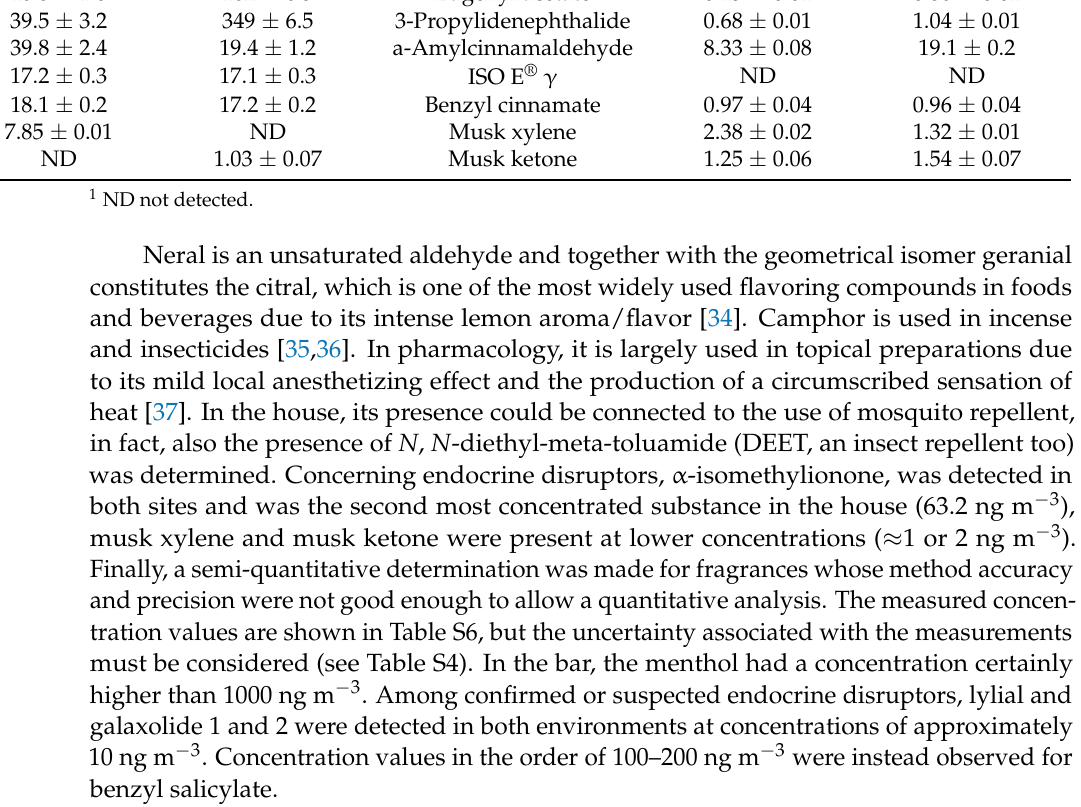
68.5 ng m − 3 (pharmacy and hairdresser respectively), and galaxolide was in the range of 47.1–1256 ng m − 3 (min. pharmacy and max hairdresser). In Spain, Reguerio et al. [21]